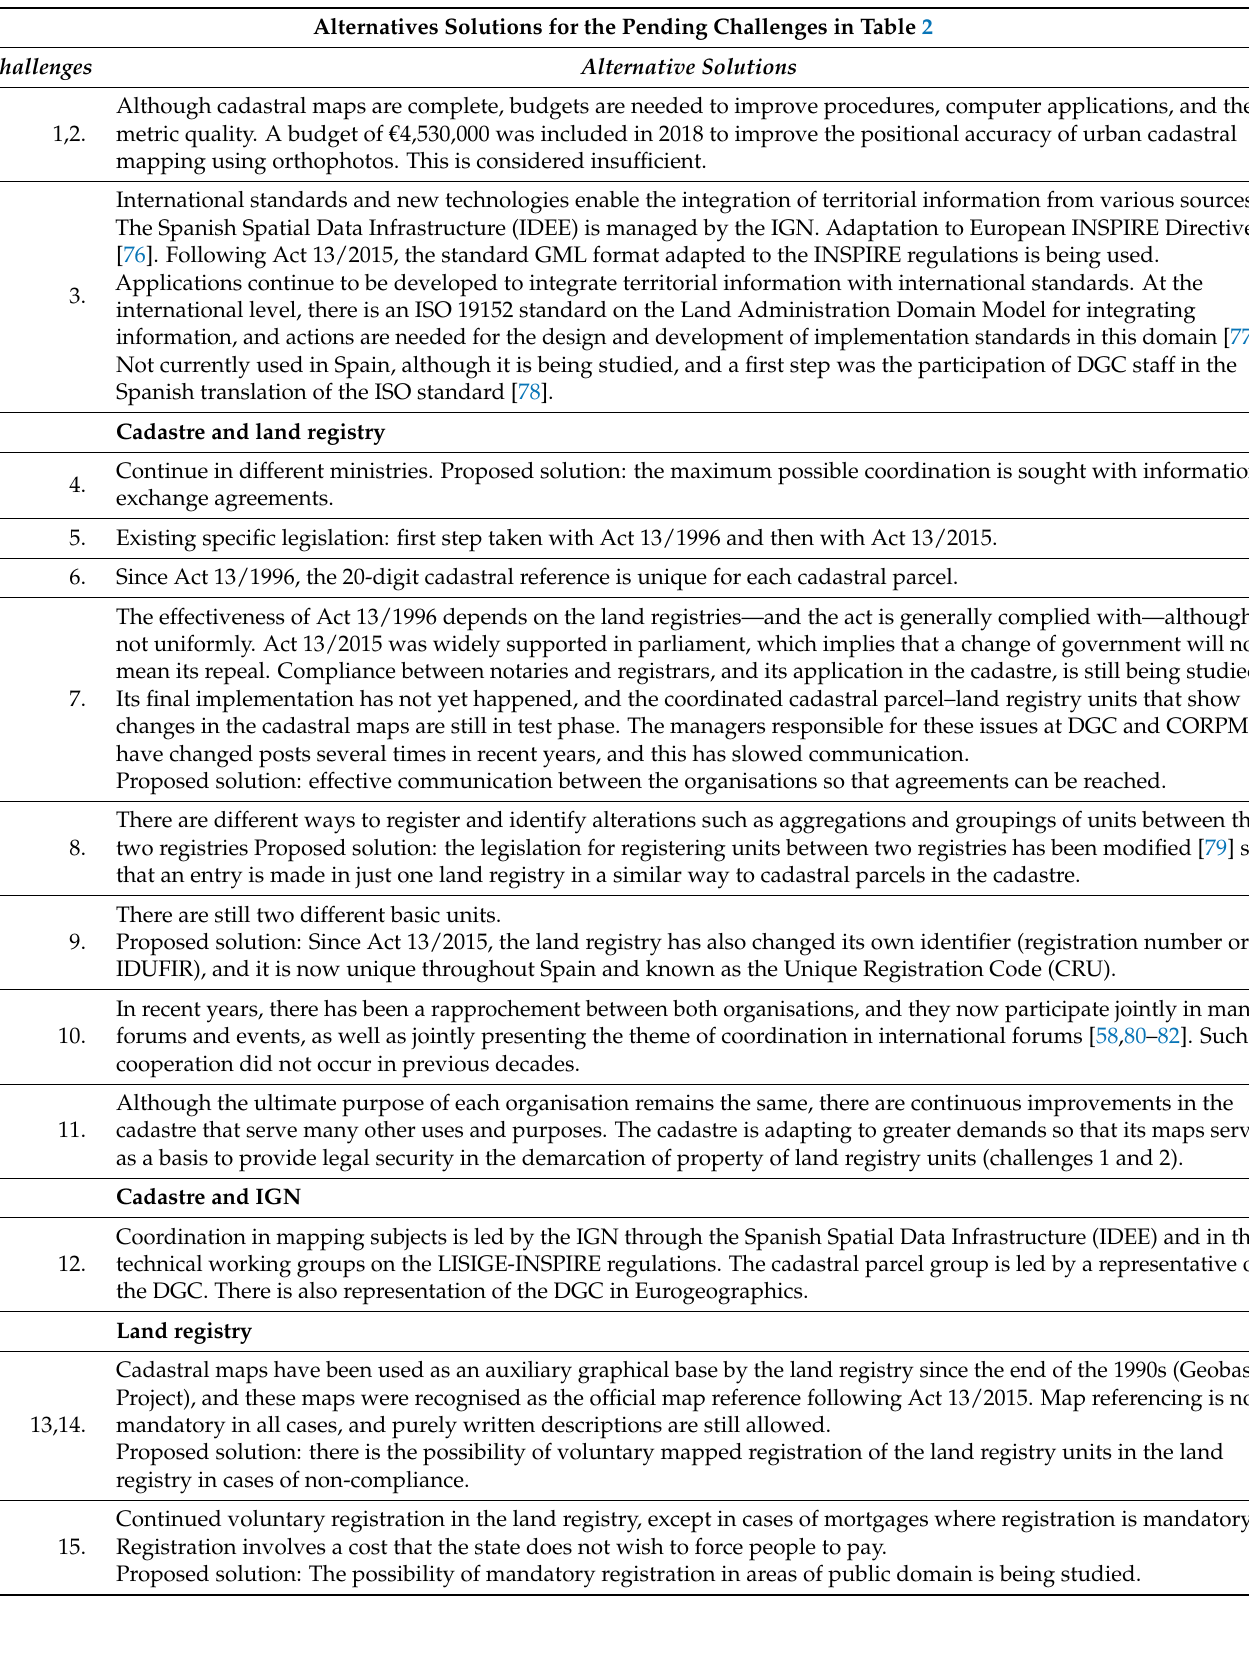
Table 3. Alternatives solutions for the pending challenges in Table 2 in order to achieve cadastre–land registry coordination in Spain. Source: